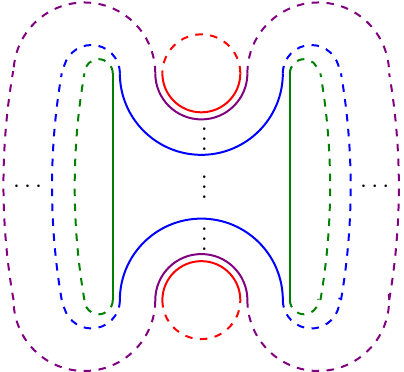
Figure 28. Example: other contribution from unbroken (melonic) ladder diagram of order O ( N 3 ) in rank- D tensor model. The unbroken ladder diagram (of green color) of order O ( N (cid:0) D +1 ) gains ( D + 2) loops in the Pillow channel of red